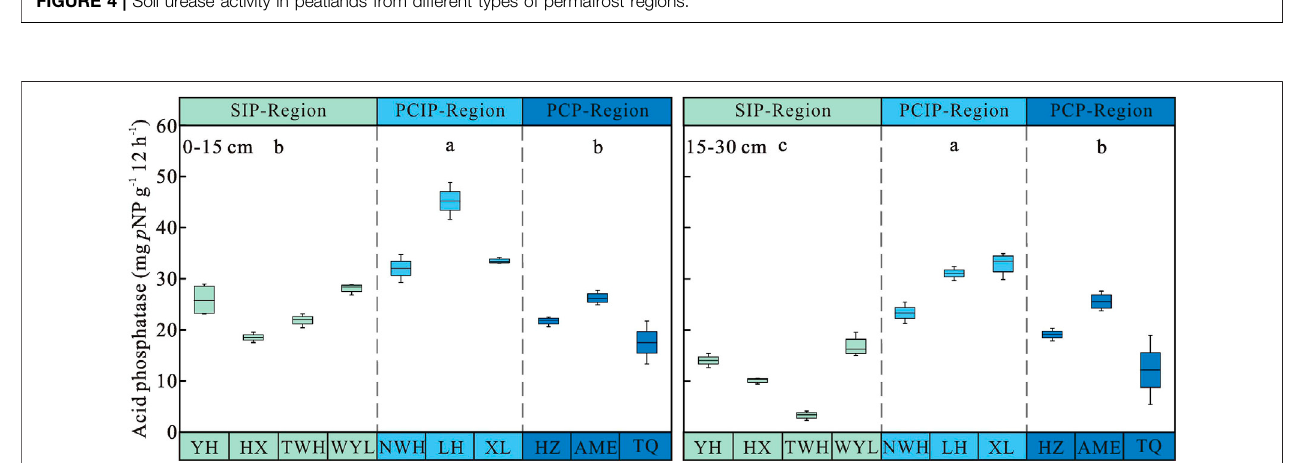
FIGURE 4 | Soil urease activity in peatlands from different types of permafrost regions.